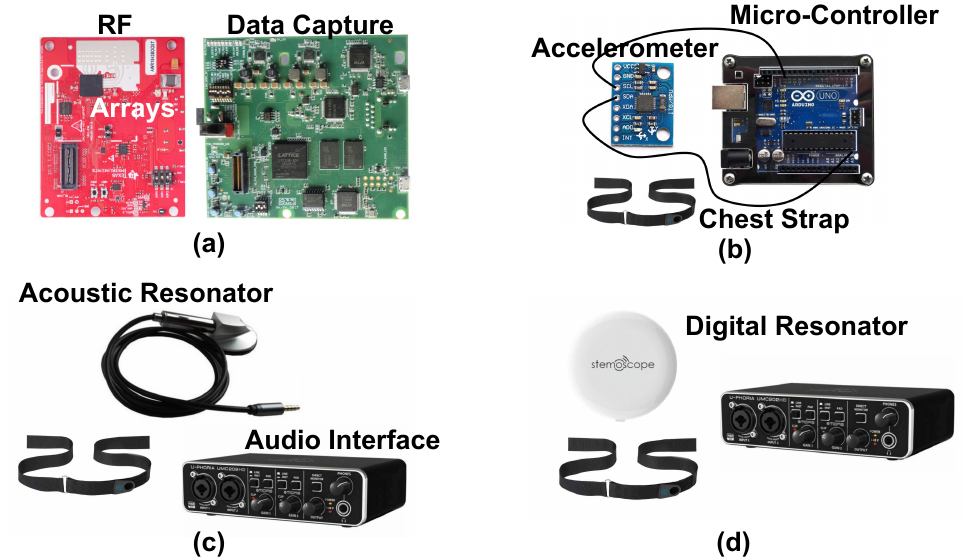
Figure 4. Photographs of the components of each of the four measurement systems used to capture heart sounds in our experiments. The radar system ( a ) consists of a radio frequency array and a data capture module. The accelerometer ( b ) is attached to the subject with a chest strap, and has a wired connection to a microcontroller for data capture. Both the acoustic ( c ) and digital ( d ) resonators attach to the chest with a chest strap. The acoustic resonator has a wired connection to the audio interface for data capture. The digital resonator wirelessly connects to a phone that then feeds the signal to the audio